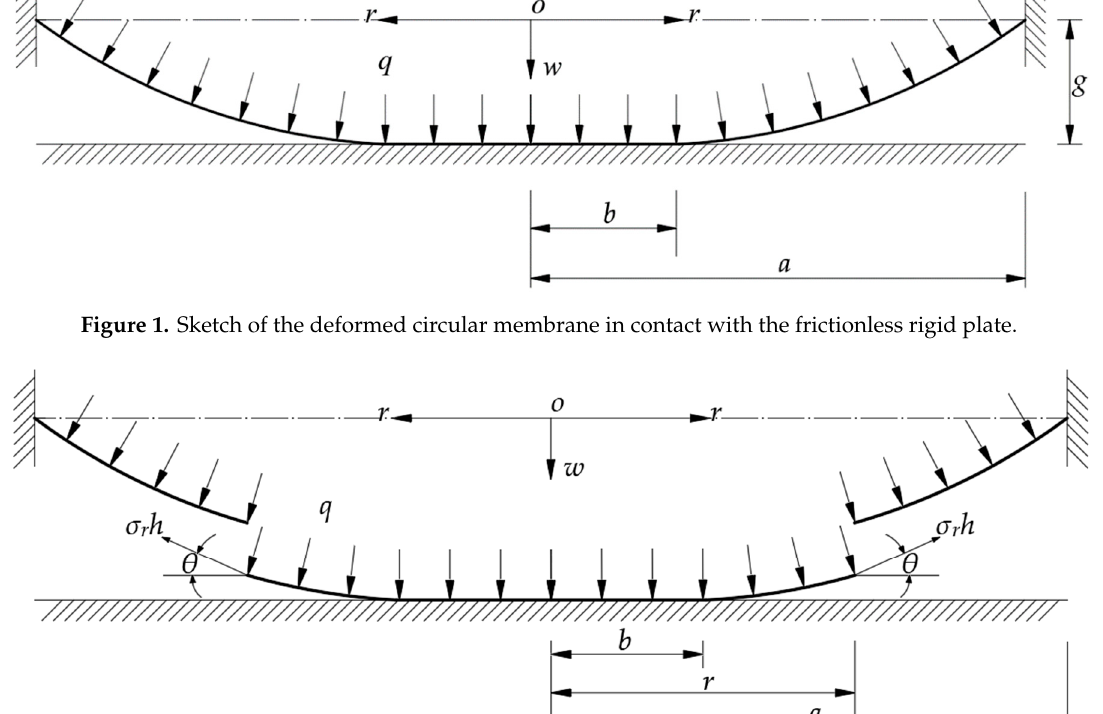
Figure 2. The free body diagram of the deformed circular membrane with radius b ≤ r ≤ a .